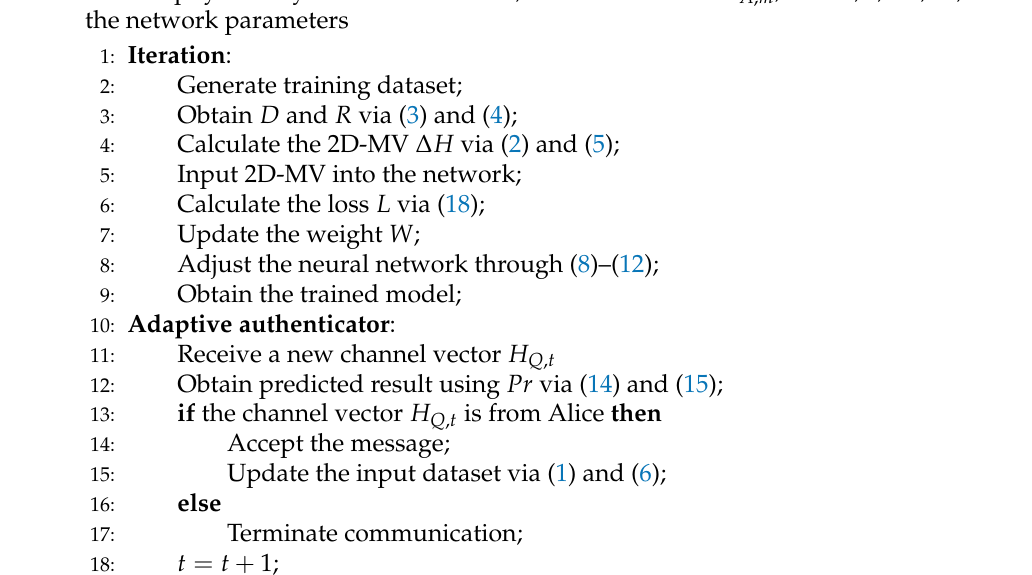
Algorithm 1 Security authentication based on Convolutional-LSTM network. Given physical layer attribute used H , Alice’s estimates H A , m , m = 1, 2, . . . , M , initialize the network